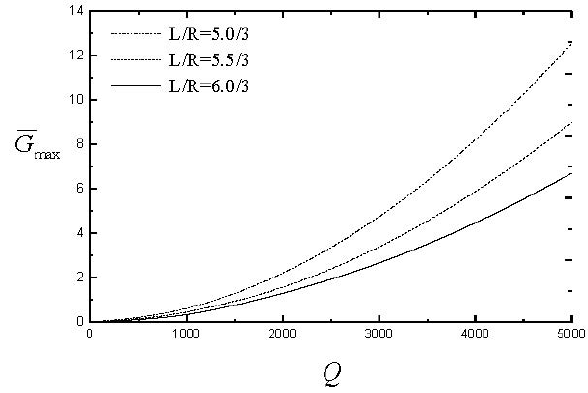
Figure 10. Effect of the ration of L / R on maximum of energy release